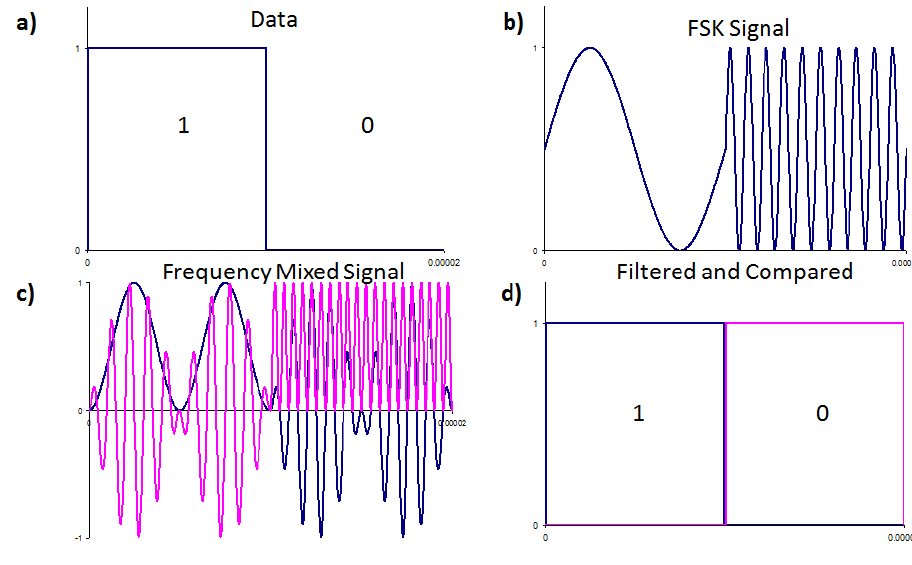
Figure 3. Decoding a frequency shift keying signal, (a) the digital data to be transmitted, (b) the frequency shift keying signal, (c) the frequency mixed signal, (d) digital information recovered after filtering and